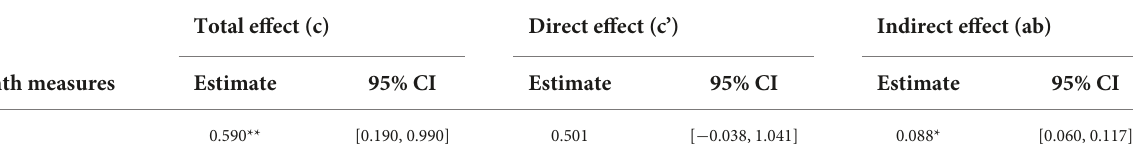
TABLE 10 Mediation analysis for lowercase letter knowledge